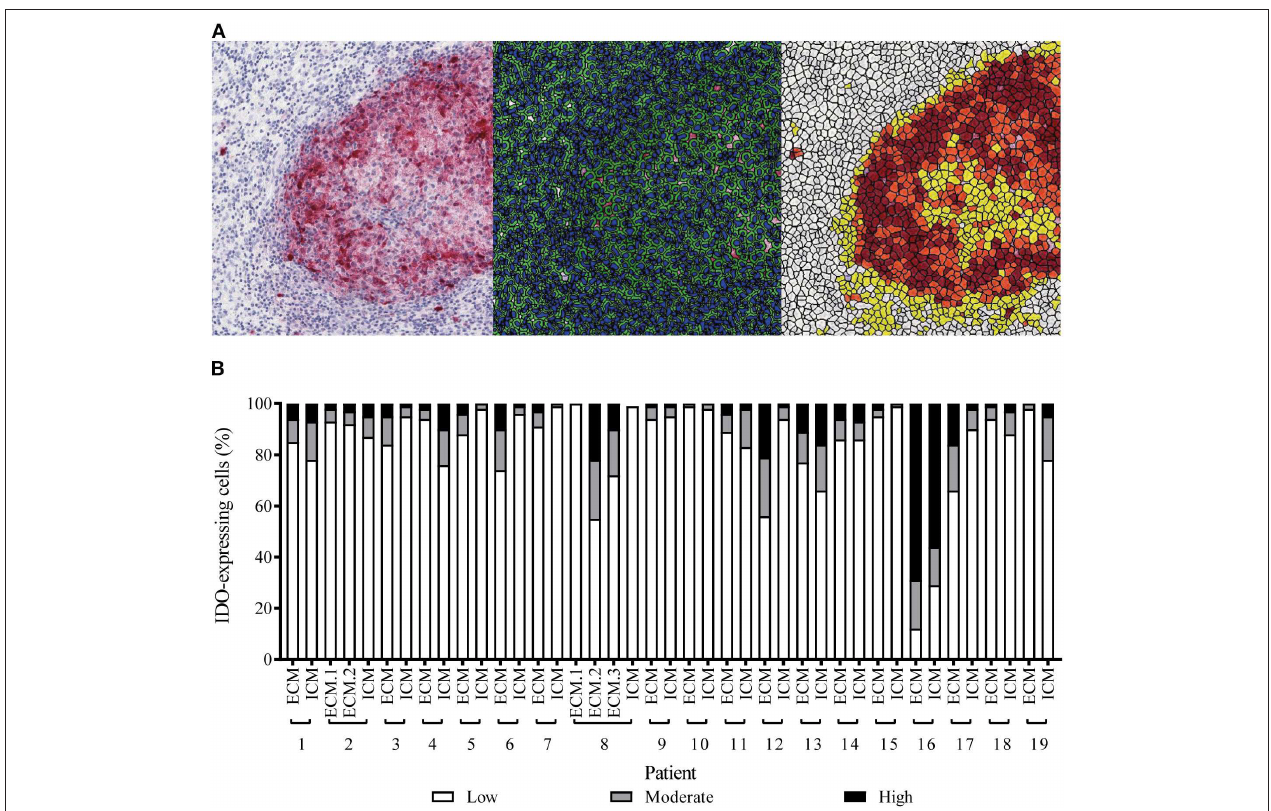
FIGURE 2 | Quantitative assessment of IDO-expression intensity in patient-matched melanoma metastases of intracranial and corresponding extracranial origin. (A) Representative images for immunohistochemical-based IDO-expression (left), parameter-based separation of cell-cell borders (middle), classification of high (brown), moderate (orange) and low (yellow) expression intensities or IDO-negative areas (white, right). (B) Statistically-based calculation for the intratumoral percentage of high (black), moderate (gray), low (white) IDO-expressing cells in intracranial (ICM) or extracranial (ECM) metastases of individual melanoma patients ( n = 19).